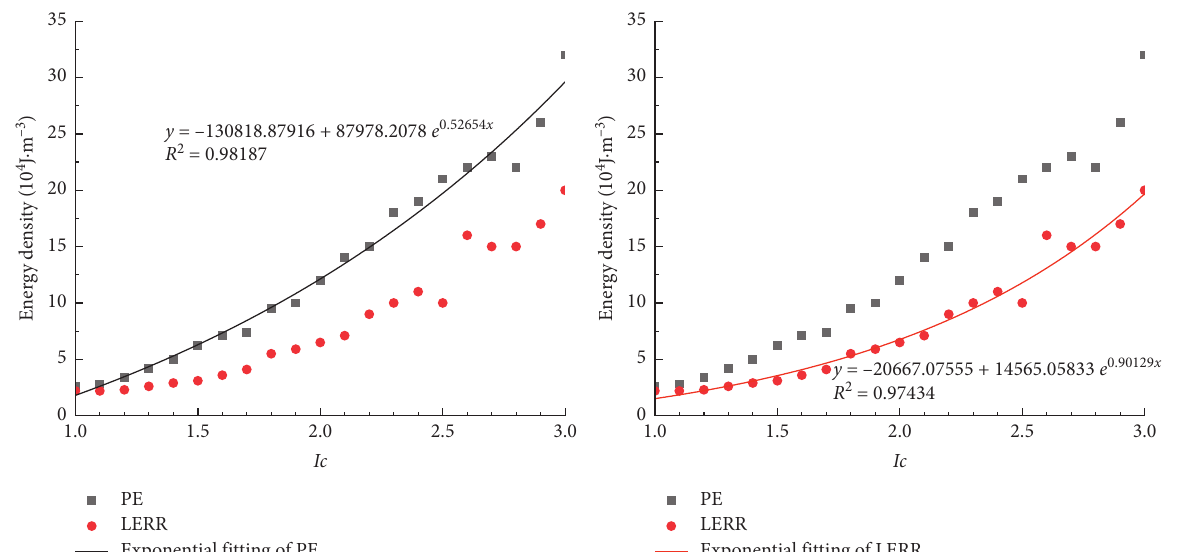
Figure 11: Statistical chart of maximum elastic energy density and local energy release rate.